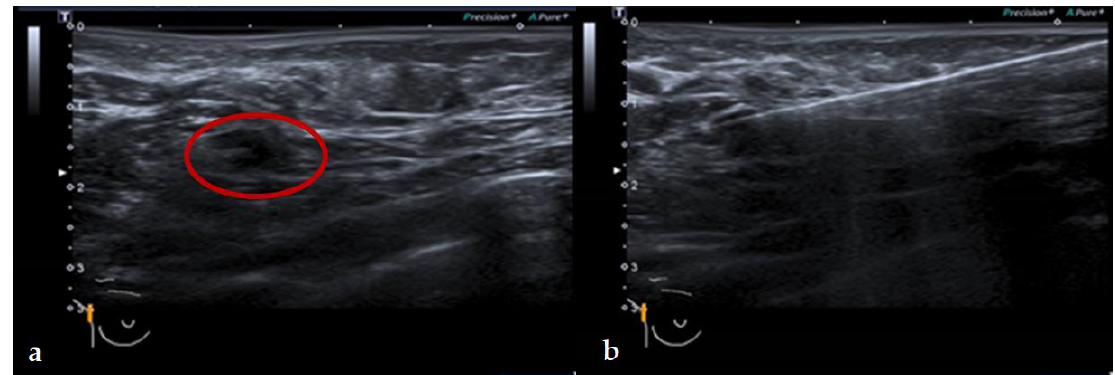
Figure 2. ( a , b ). MagUS with the SLN visualized in the red circle ( left ). Magnetic probe localizes the magnetic “hotspot” and after that CNB is performed ( right ). Monitor width 3.9 cm.